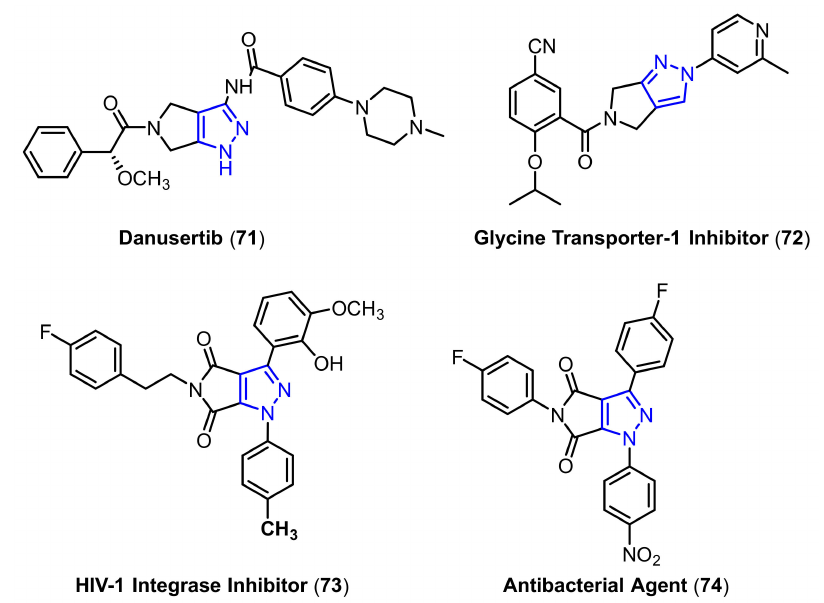
Figure 3. Bioactive molecules containing pyrrolopyrazole